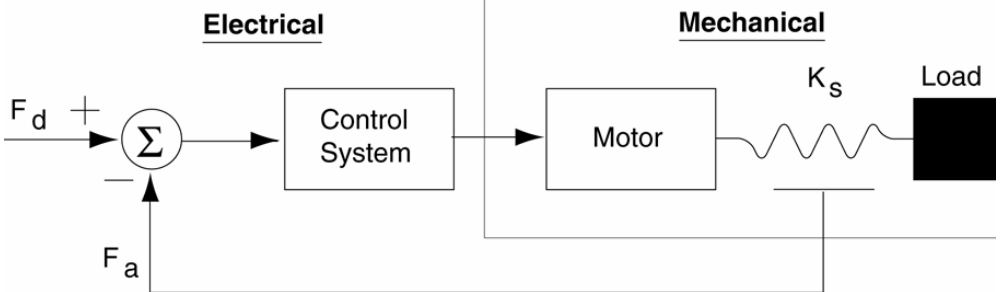
Figure 15. Schematic diagram of a Series Elastic Actuator